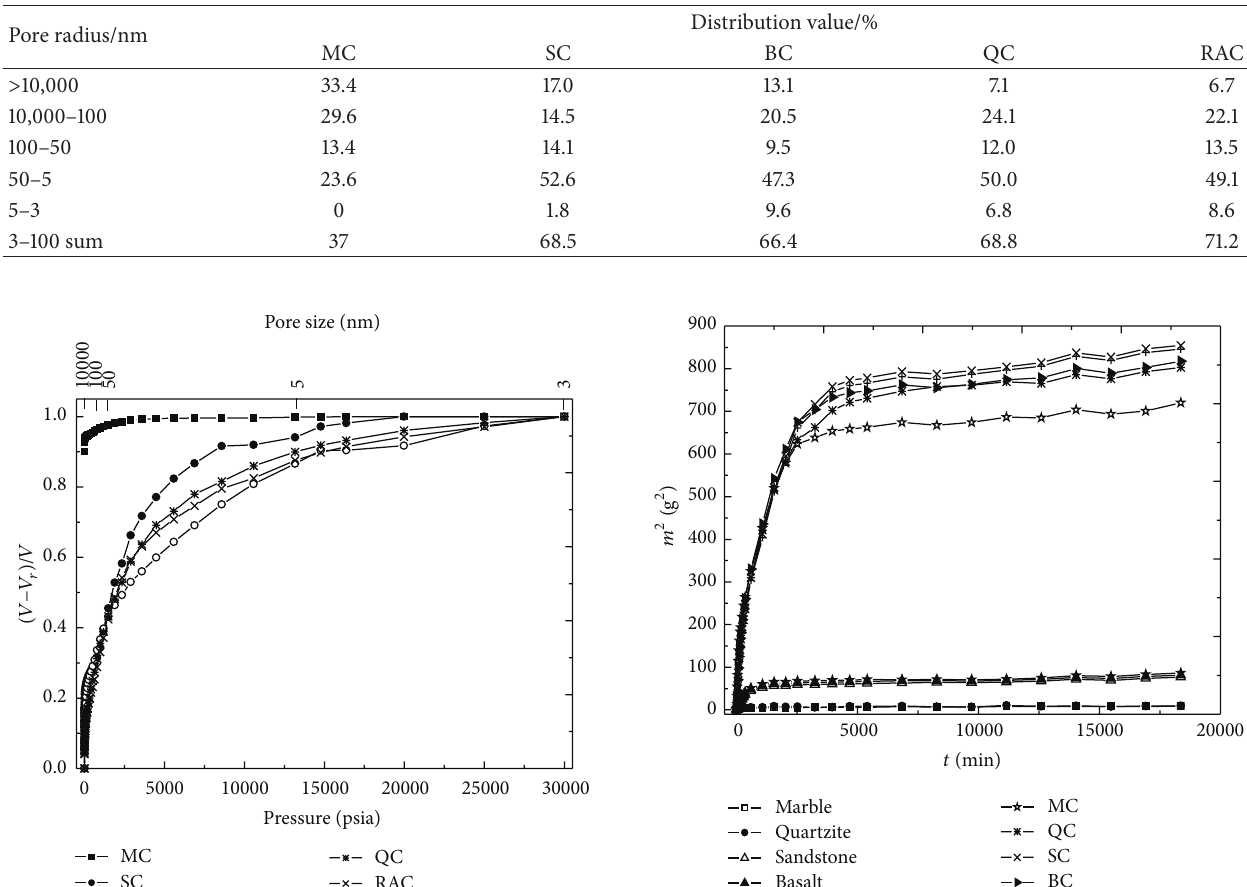
Table 4: Pore distribution ratios of different coarse aggregate concretes.